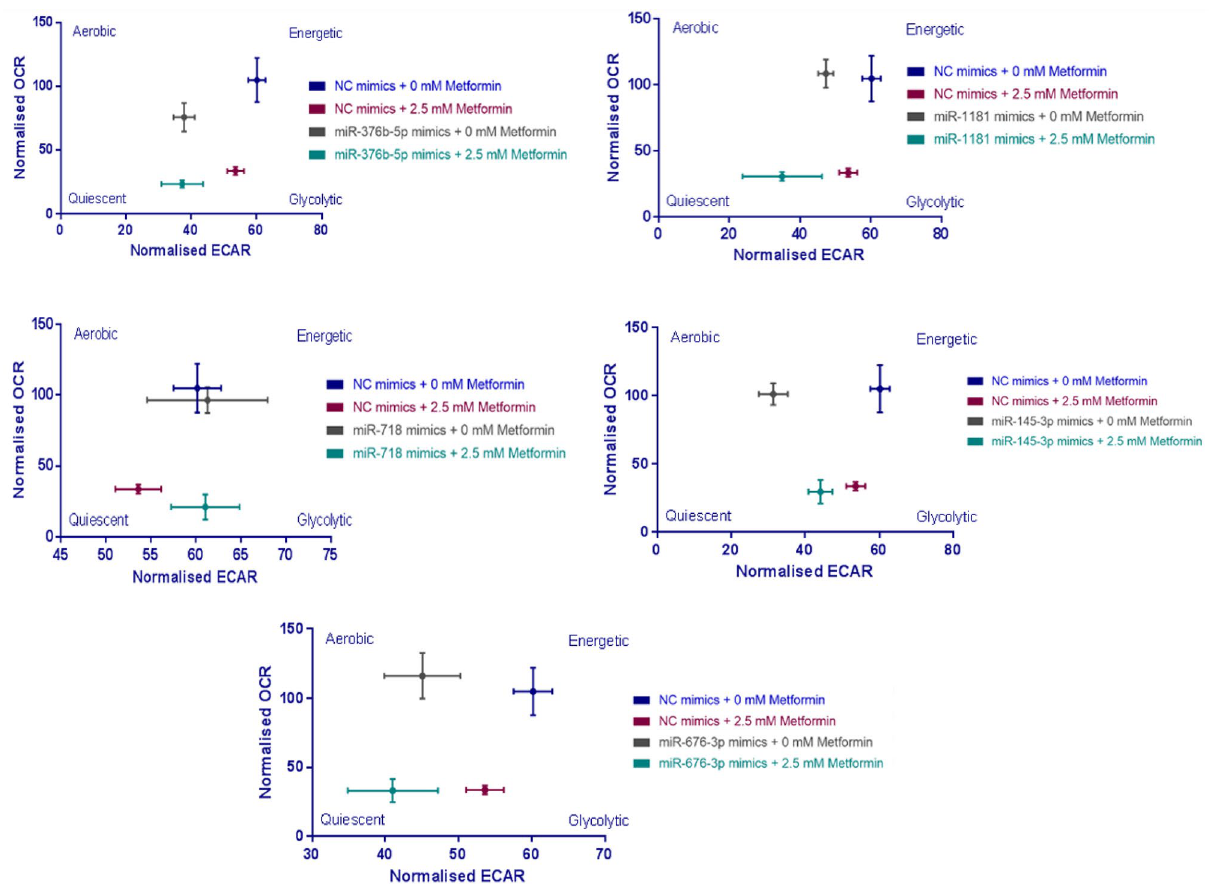
Figure 5. Integrated energy maps of HCT116 cells associated with miRNA mimic transfections in combination with metformin treatment. CRC cells were reverse transfected with selected miRNA mimics and treated with 2.5 mM metformin treatment or control medium. The baseline oxygen consumption rate (OCR) and extracellular acidification rate (ECAR) calculated were combined to generate the basal phenogram. The OCR and ECAR values were normalized to viability of the corresponding cells acquired by crystal violet assay. Results are expressed as mean ± SD of 3 technical